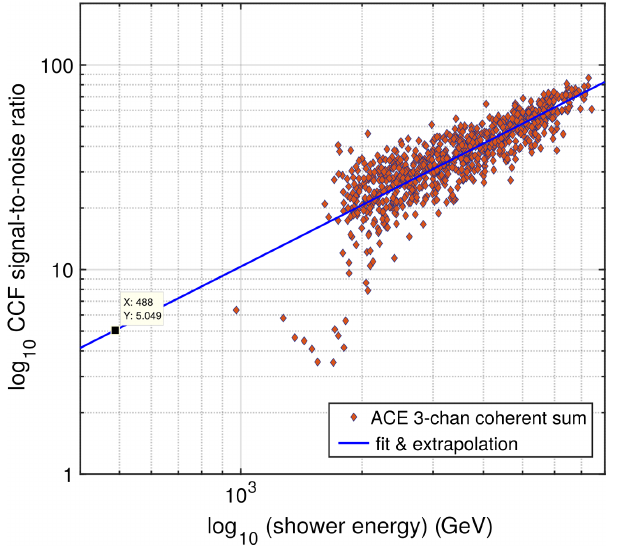
FIG. 13. Energy resolution of a single ACE detector element, estimated against a quasicalibrated second ACE element. The errors here are a convolution of the intrinsic errors of two ACE elements; no deconvolution of the errors has been